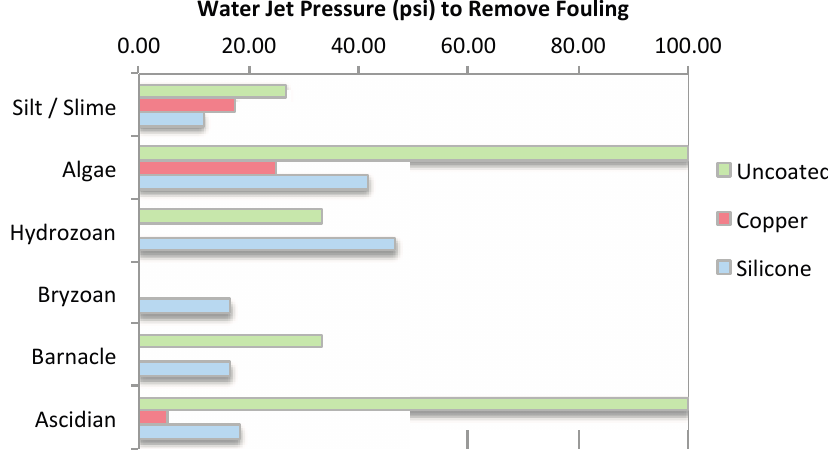
Figure 3. Average water-jet pressure required to remove the major fouling categories from the different net